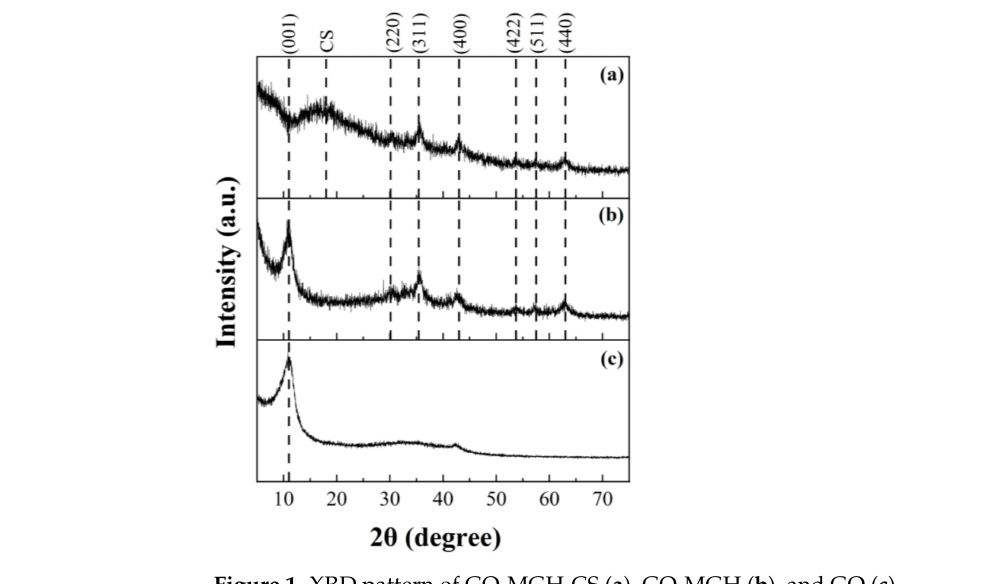
Figure 1. XRD pattern of GO-MGH-CS ( a ), GO-MGH ( b ), and GO ( c ). Table 1. Parameters of Mössbauer spectra: T —measurement temperature, M —mass percentage of maghemite, I d and I B —relative area of doublet and hyperfine distribution or sextet, respectively,